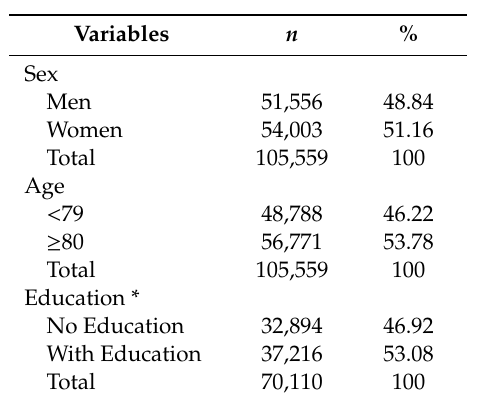
Table 1. Characteristics of deaths in summer (1 June–30 September) during the study period 1992–2015 in Barcelona.